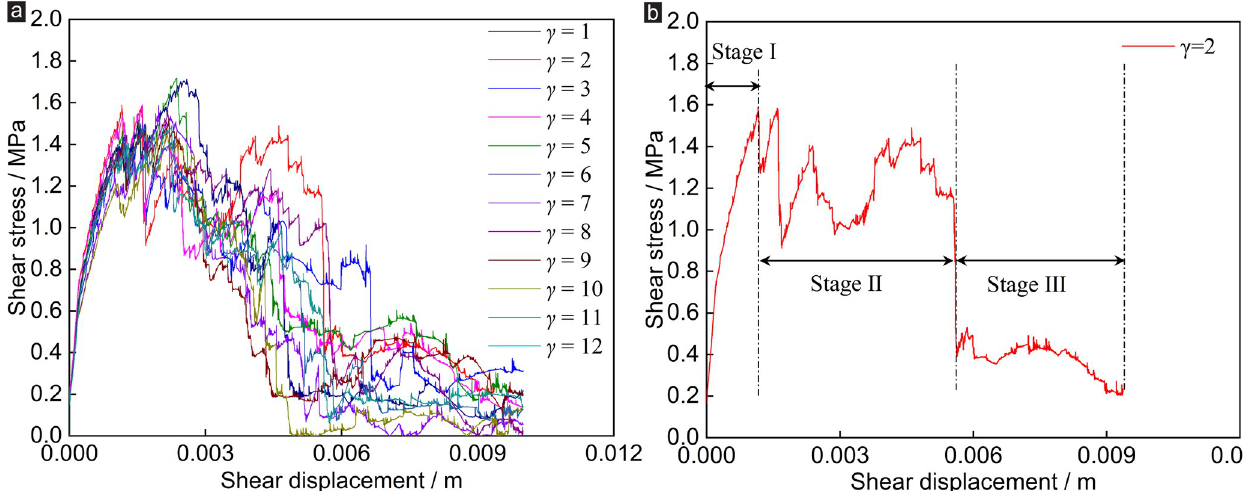
Fig 4. Effect of γ on shear stress of rock joints under CNS conditions: (a) shear stress vs. shear displacement, (b) shear stress vs. shear displacement of γ = 2.